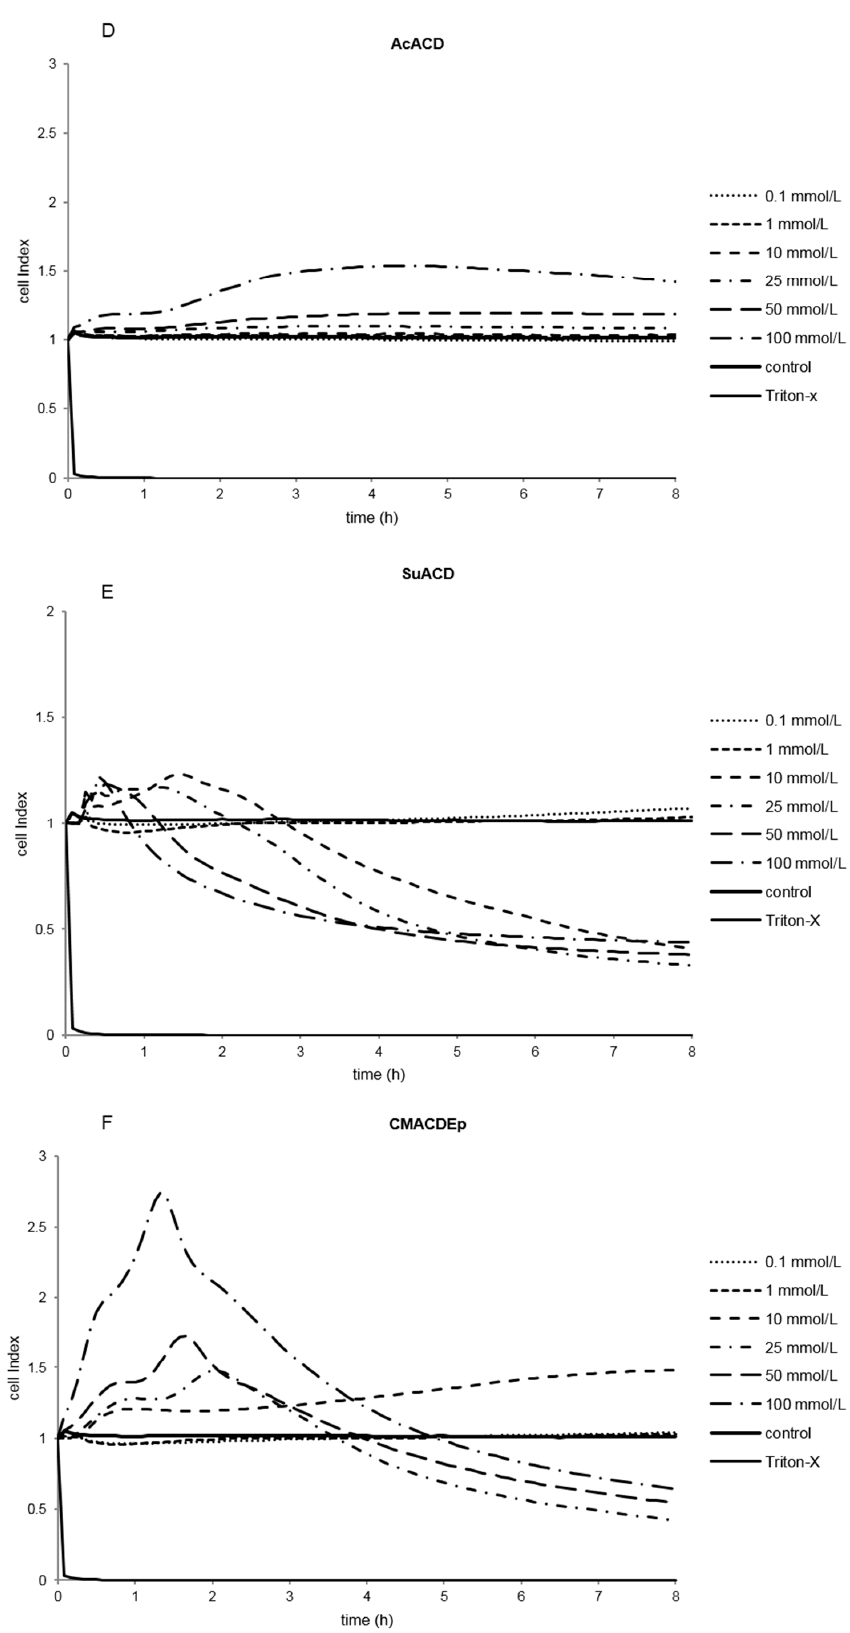
Figure 3. Cont. Figure 3.